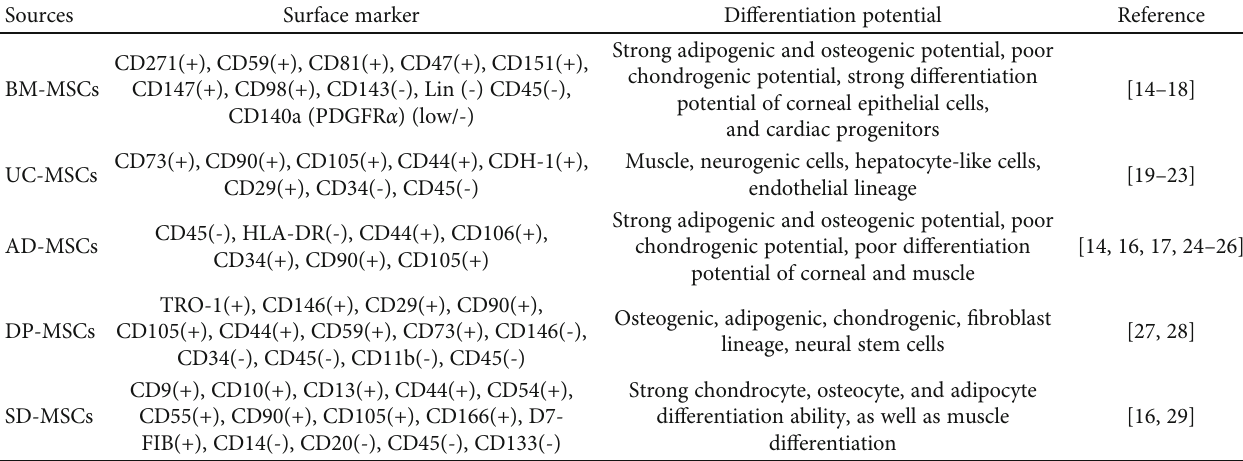
Table 1: The surface markers and di ff erentiation potential of di ff erent kinds of